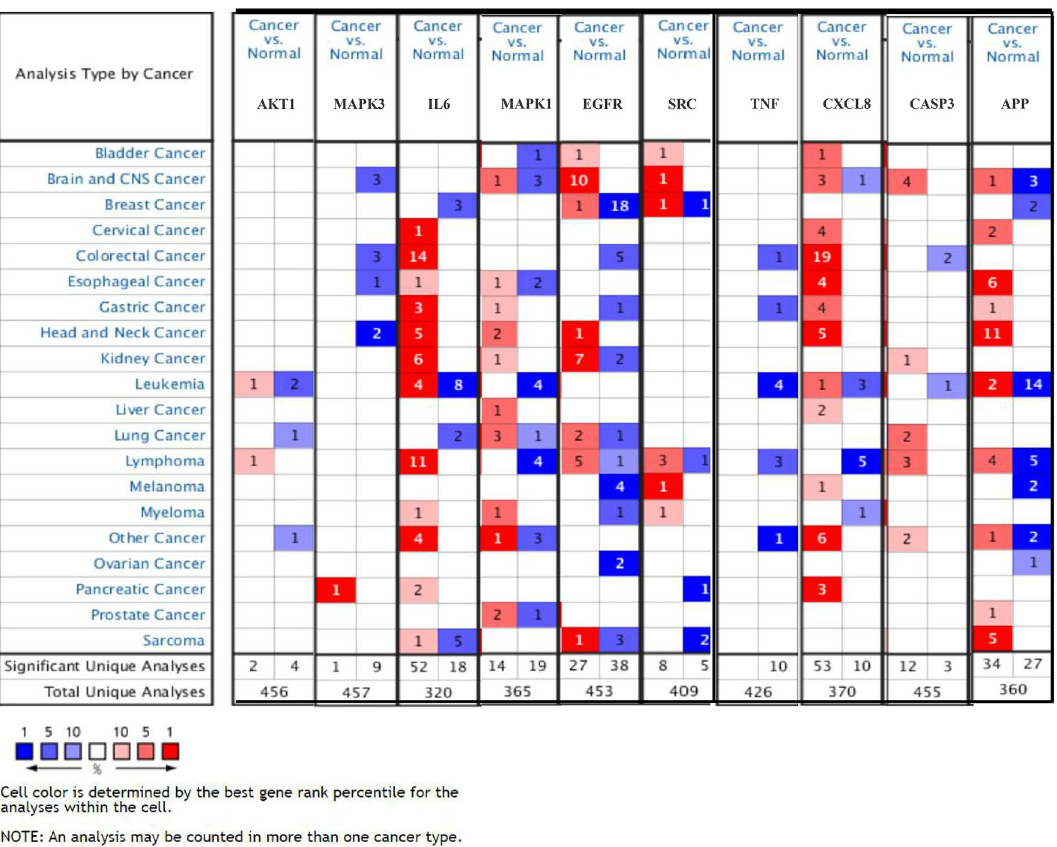
Figure 9. mRNA expression levels of hub targets. The red box indicates the overexpression of the gene in tumor tissues, while the blue box indicates the downregulation of the targets. The intensity of expression is expressed in shades of